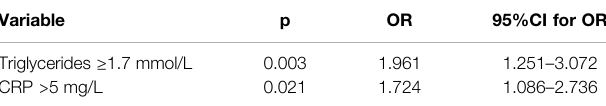
TABLE 3 | Demographic data and comorbidities of the study population according to metabolic syndrome.